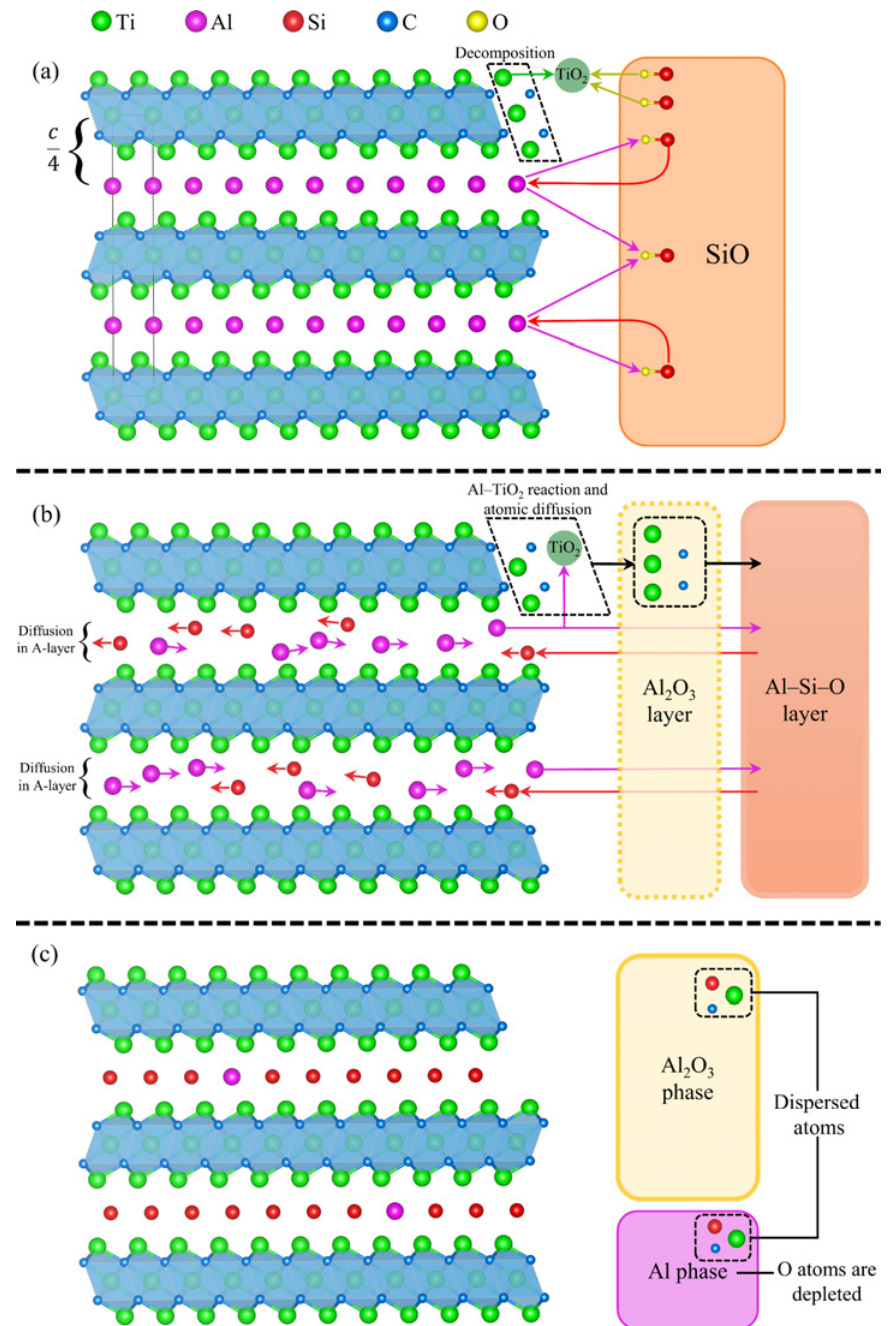
Fig. 9 Schematic illustration of the reaction path: (a) chemical reaction between Ti 3 AlC 2 and SiO; (b) atomic diffusion through the MAX phase, Al 2 O 3 layer (not densified), and Al–Si–O layer; (c) Ti 3 (Si,Al)C 2 , Al 2 O 3 phase, and Al phase in the sintered CAS sample and HP